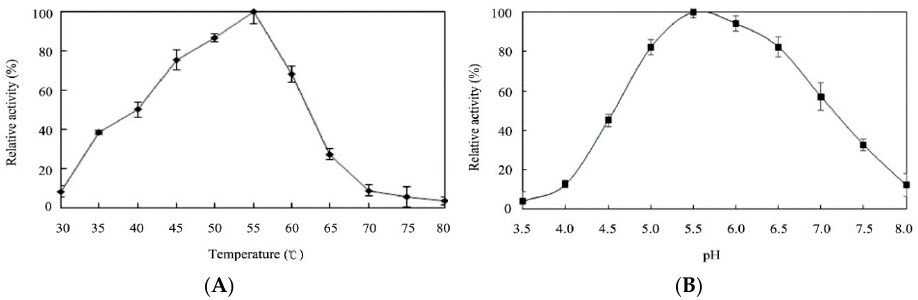
Figure 3. Temperature optima ( A ) and pH optima of the r ‐ Ao FT( B ). ( A ) Temperature optima of r ‐ Ao FT was determined with sucrose and glucose 6 ‐ acetate as substrates in 50 mM sodium acetate buffer (pH 5.5) at temperatures ranging from 30 °C to 80 °C; ( B ) pH optima of the enzyme at pHs ranging from 3.5 to 8.0 was measured for 24 h at 55 °C. The buffers used were 50 mM of sodium citrate (pH 3.5 to 4.0), sodium acetate (pH 4.5 to 6.0), and sodium phosphate (pH 6.5 to 8.0). The values are means of three independent